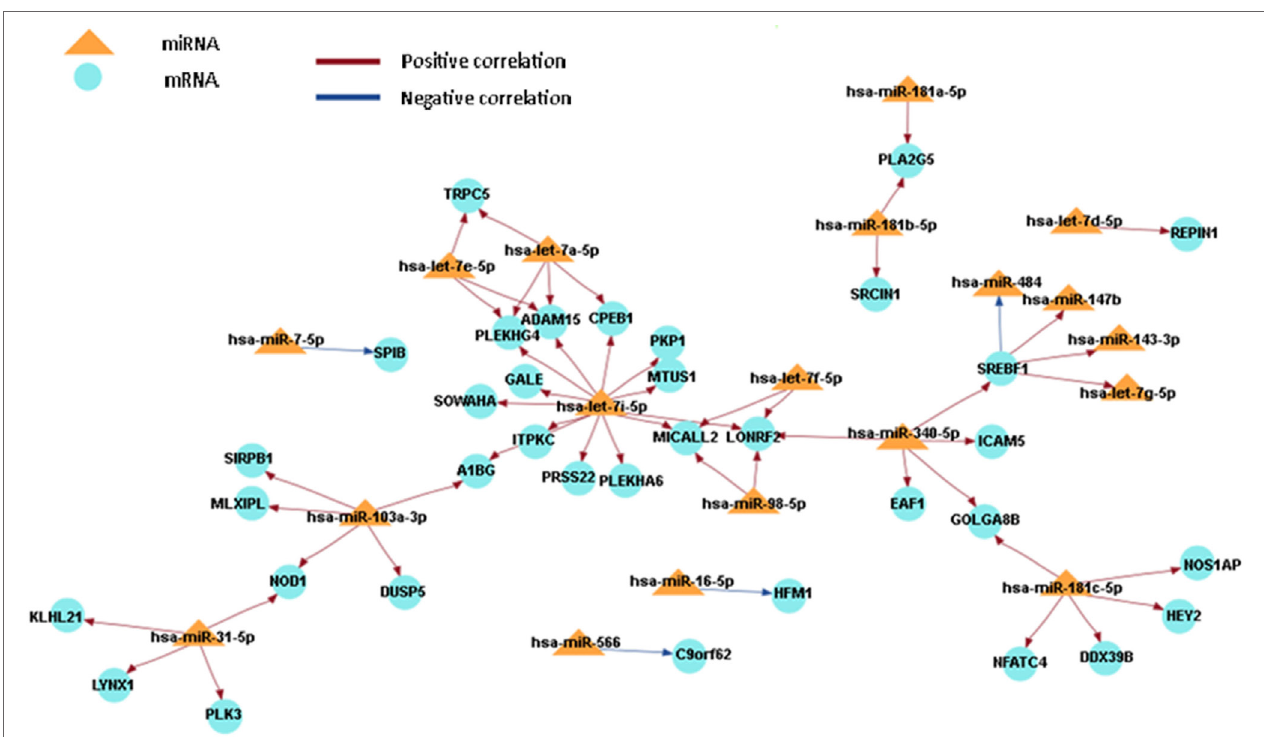
FigUre 6 | Grand view for 200 main significant microRNA (miRNA)–gene interaction that was generated using miRNA and gene that have significant expression in papillary thyroid carcinoma LNM-P versus their adjacent normal group.